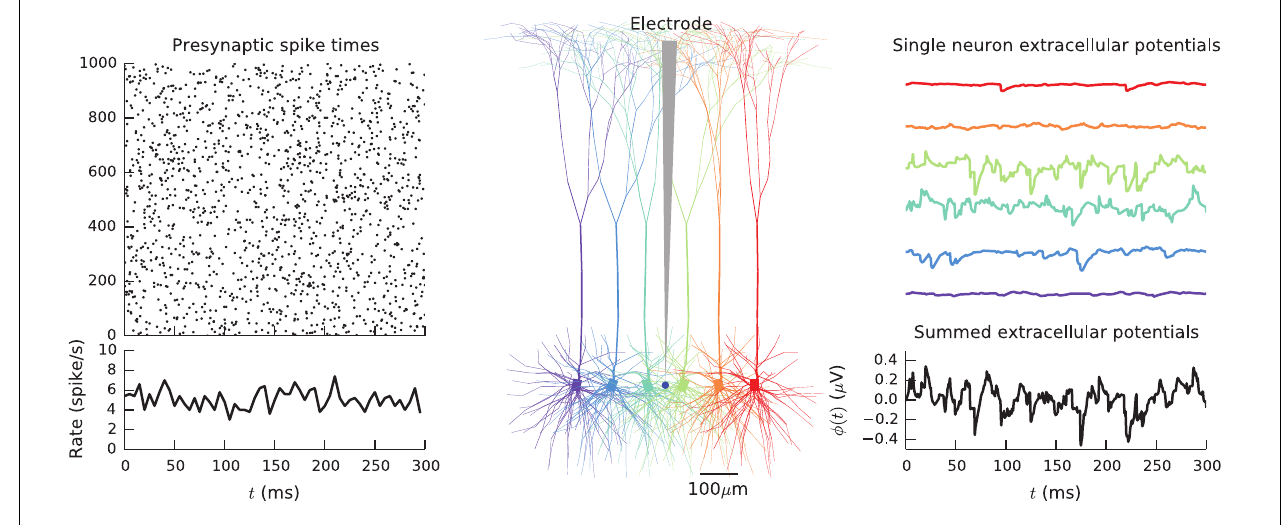
FIGURE 4 | Simulation of extracellular potentials from a population of neurons using MPI. A population of pyramidal cells ( Middle panel) receiving input spikes from a presynaptic pool of spike trains ( Left panel) is simulated by distributing cells on different MPI processes and